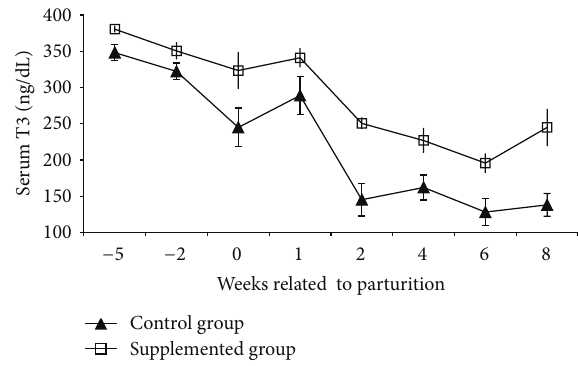
Figure 3: Serum T3 concentrations (mean ± SEM) of Se supple- mented and control ewes.